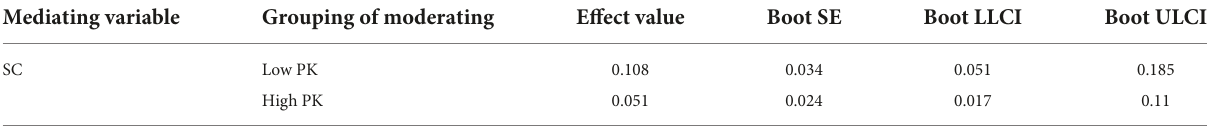
TABLE 7 Conditional indirect effects of information quality (IQ) on travel intention (TI) via self-congruity (SC) at levels of prior knowledge (PK). Mediating variable Grouping of